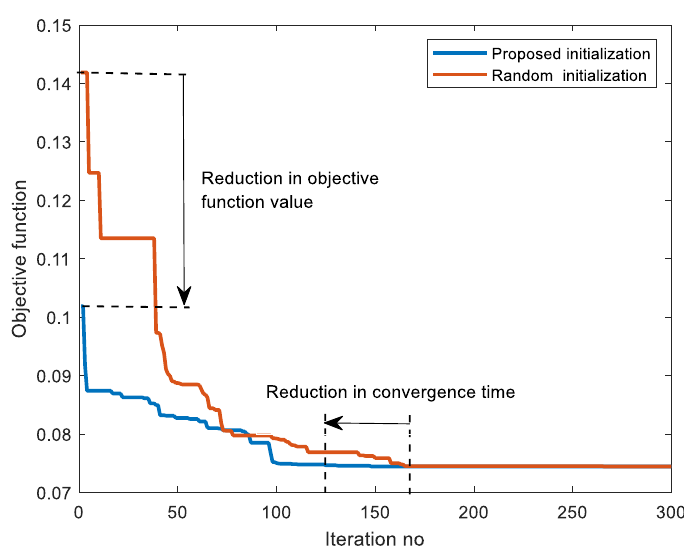
Figure 14. The convergence of MLPSO algorithm for proposed and random particle initialization.